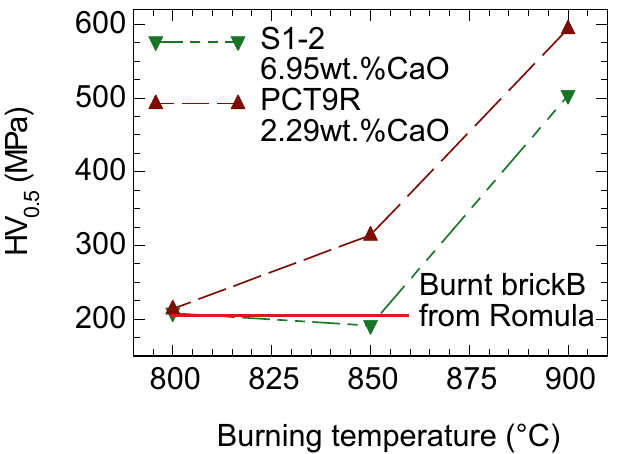
Figure 14. Vickers hardness measured on burnt brick B and ceramic samples manufactured in the lab from the as-excavated soil PCT9R with low content of calcium and from the mud brick (S1–2) rich in